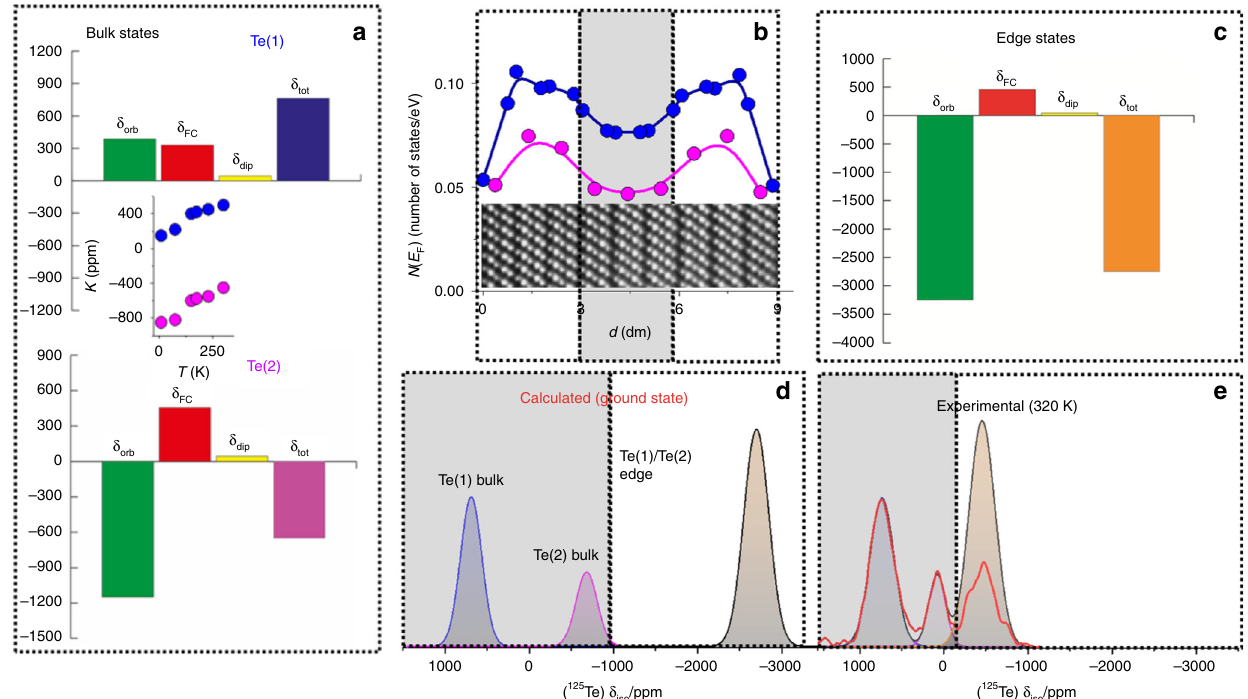
Fig. 4 DFT analysis of the 125 Te NMR Knight shifts in Bi 2 Te 3 nanoplatelets. a Calculated 125 Te orbital (green), Fermi contact (red), and dipolar terms (light yellow) of the Knight shift of bulk Bi 2 Te 3 (SOC is set on). The inset shows the temperature dependence of the Knight shift according to experimental data in ref. 14 . b The Te(1) and Te(2) DOS at the Fermi level N ( E F ), across a 9-quintuplet ( ∼ 9 nm) Bi 2 Te 3 slab. The gray-shaded area marks a central region in the slab with “ bulk-like ” character, i.e. signi fi cant drop of the DOS. c Calculated 125 Te Knight shift of a 5-quintuplet Bi 2 Te 3 slab (SOC is set on). d Simulation of the 125 Te NMR signal of a 9-quintuplet slab, by combining calculated bulk and edge state Knight shifts. The bulk/edge intensity ratio was set according to the number of Te sites in in the central (gray-shaded) and edge areas in panel b . Calculated NMR lines were convoluted with a Gaussian function. e The experimental isotropic 125 Te NMR spectrum of the Bi 2 Te 3 nanoplatelets. The NMR signal from the edge states at − 452 ppm was corrected to account for differential T 0 signal 2